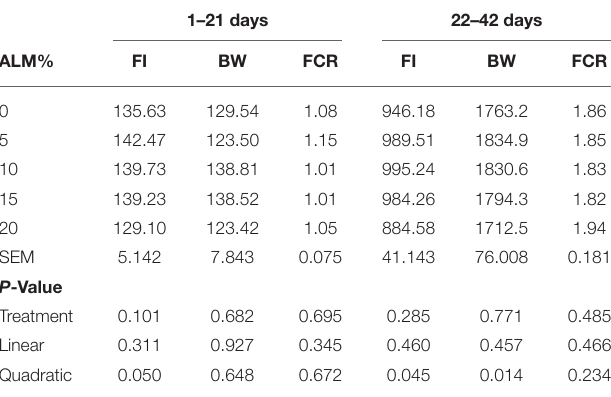
TABLE 3 | Effect of amaranth leaf meal inclusion on feed intake (FI) (g/bird), weight gain (gain, g/bird), and feed conversion ratio (FCR) (g:g, FI:BWG) of Ross 308 broiler chickens.